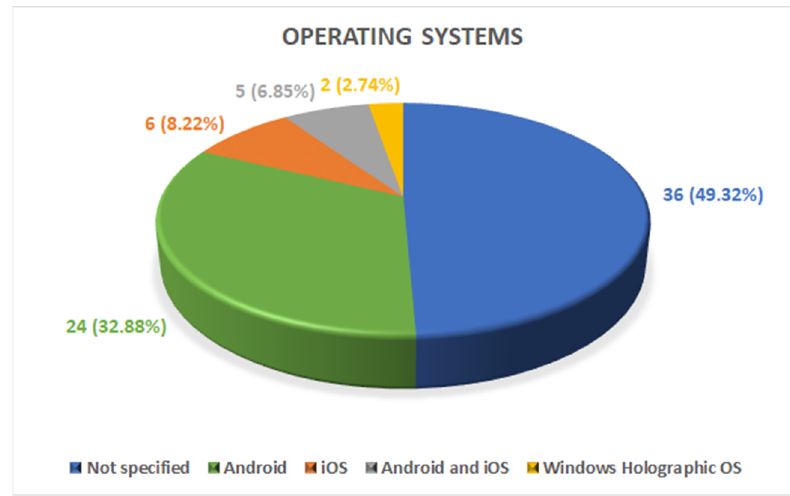
Figure 6. Empirical studies: operating systems. Table 5. Proposal and prototype papers: general